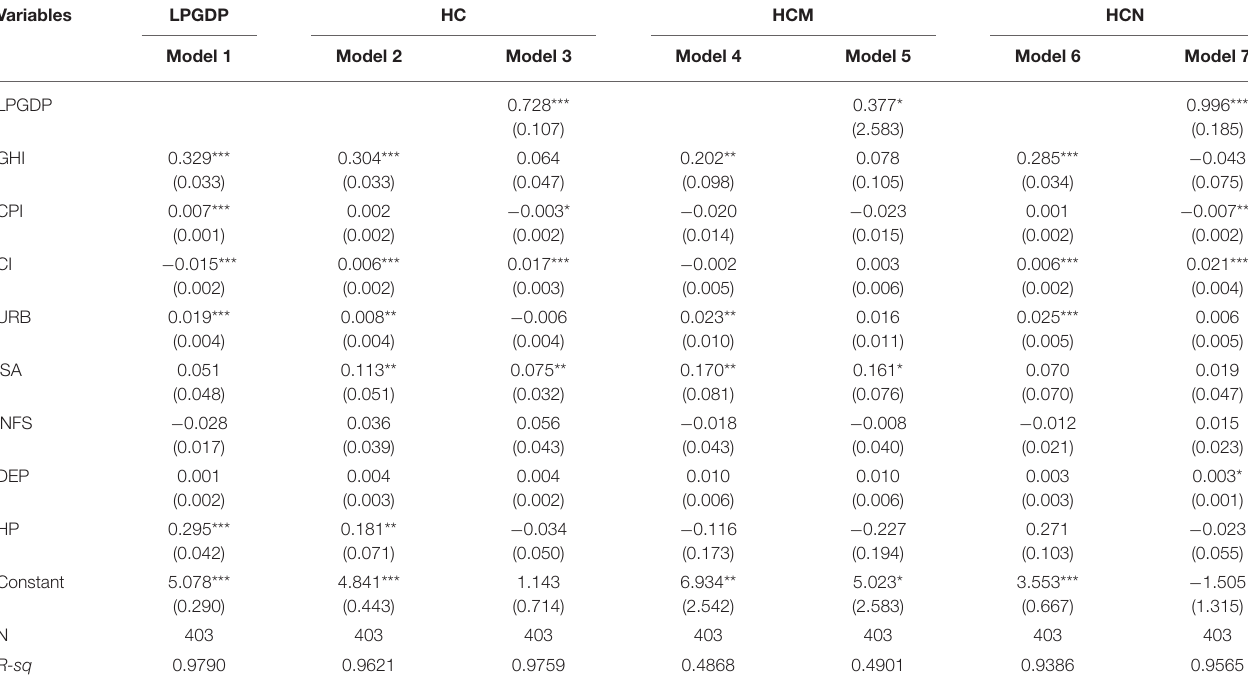
TABLE 8 | Mechanism analysis of government health investment and household